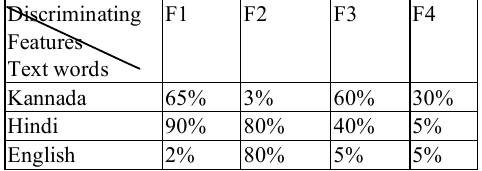
Table-2. Percentage of the presence of discriminating features of Kannada, Hindi and English text words. (F1: Horizontal lines; F2: Vertical lines; F3: Variable sized blocks; F4: Blocks with more than one component ) Discriminating